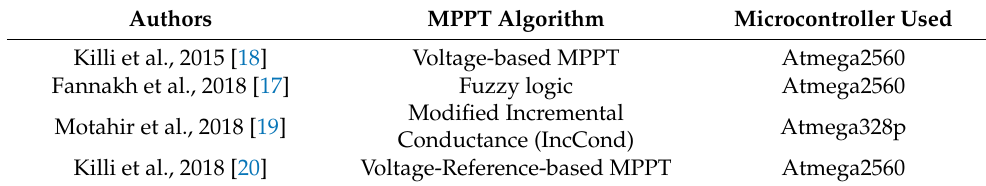
Table 1. MPPT algorithms experimentally validated using the Arduino